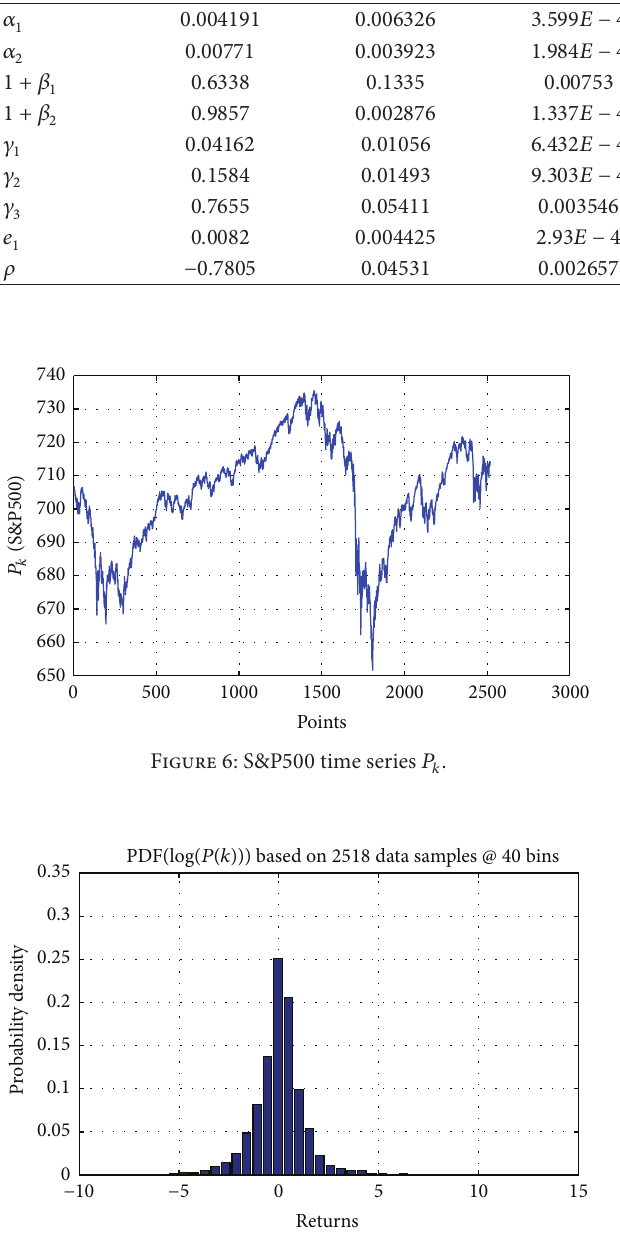
Figure 7: The probability histogram of